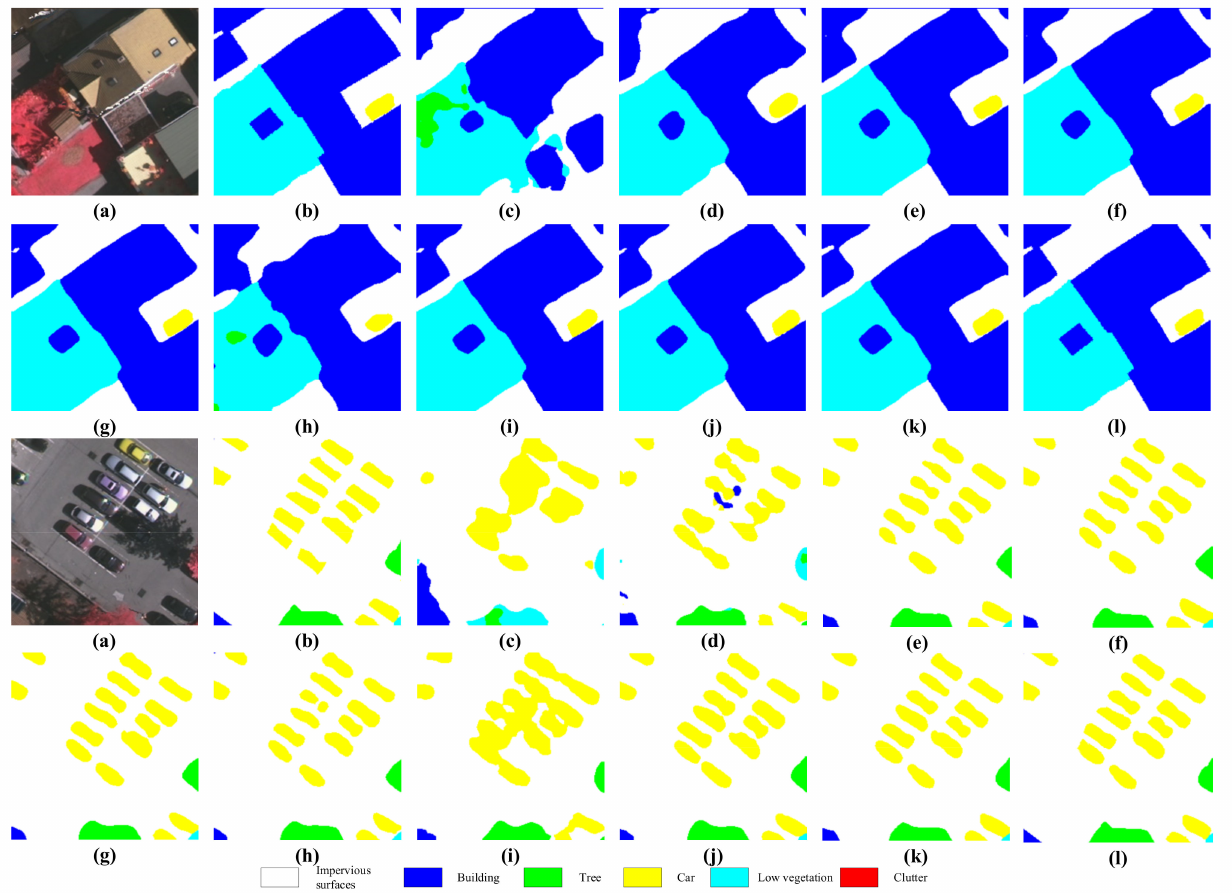
Figure 6. Visualization results on the Vaihingen test set. ( a ) Original image, ( b ) Ground truth, ( c ) SegNet, ( d ) U-Net, ( e ) DeepLab V3+, ( f ) CBAM, ( g ) DANet, ( h ) OCNet, ( i ) NLNet, ( j ) ResUNet-a, ( k ) SCAttNet, ( l )